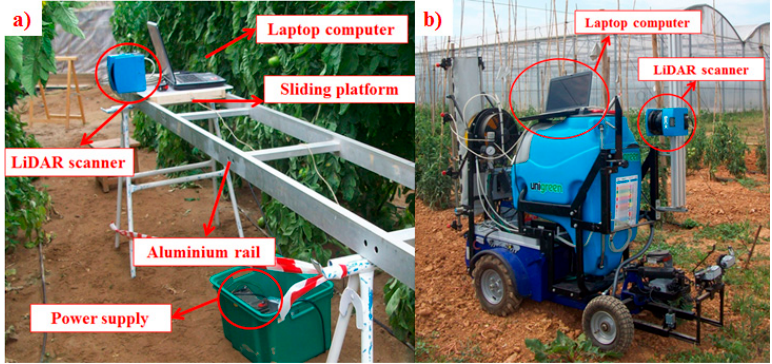
Figure 3. ( a ) Fixed structure of the LiDAR support system for measurements in greenhouses 1 and 2; ( b ) LiDAR scanner mounted on a radio-controlled mobile platform for measurements in greenhouse 3. The mobility of the autonomous platform in GH3 enabled scanning the entire tomato row (23.4 m